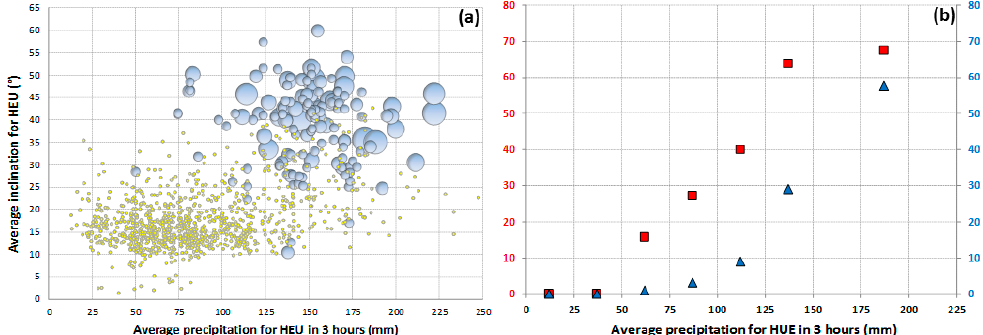
Figure 5. ( a ) Number of ground effects recognized in hydrogeomorphologic elementary units (HEUs), plotted with rainfall intensity (mm/3 h) and HEUs mean slope steepness. Yellow dots correspond to (HEUs) without flow processes, gray-shaded circles are the HEUs that were interested by flow processes, the size of circles is proportional to the number of processes, from a minimum of 1 (smallest circles) to a maximum of 8 (largest circles). ( b ) Only HEUs with average acclivity of more than 25° are reported. The figure shows the relationship between the percentage of mass flows triggered per HEU (red square), and the number of HEUs where mass-flows were recorded (blue triangle) in relation to average precipitation for HEU in 3 h.